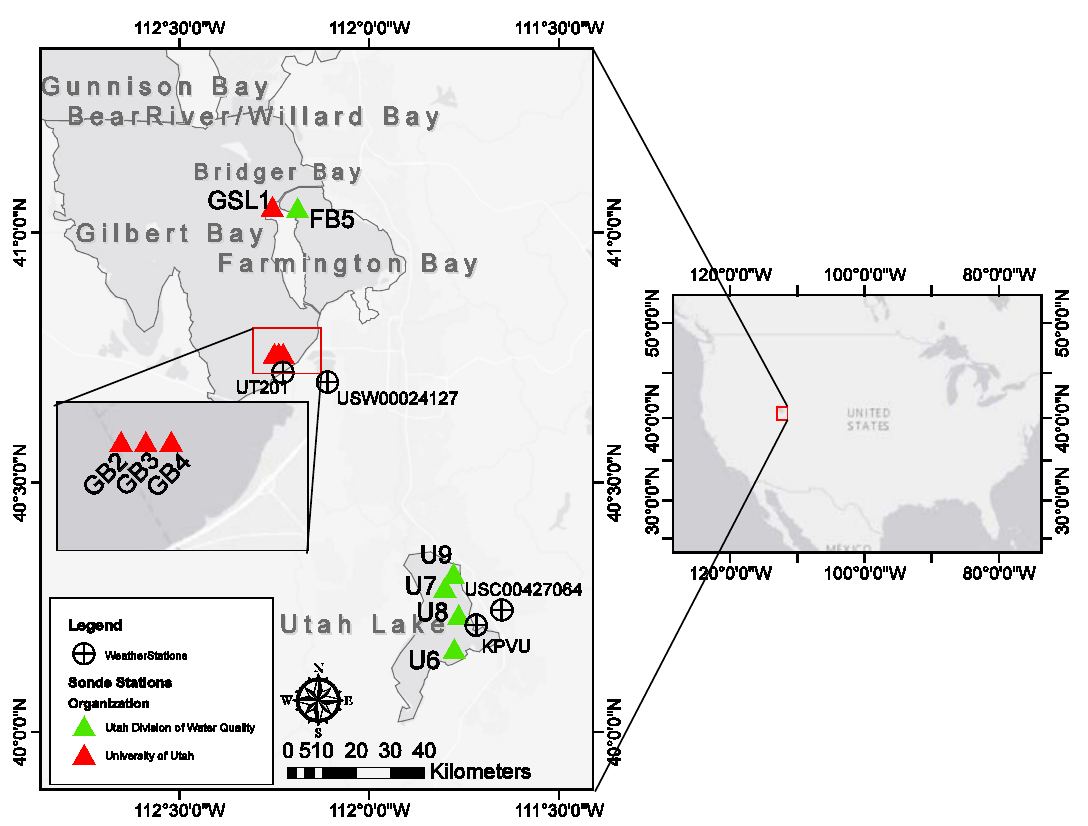
Figure 1. Sampling Locations and Study Area.